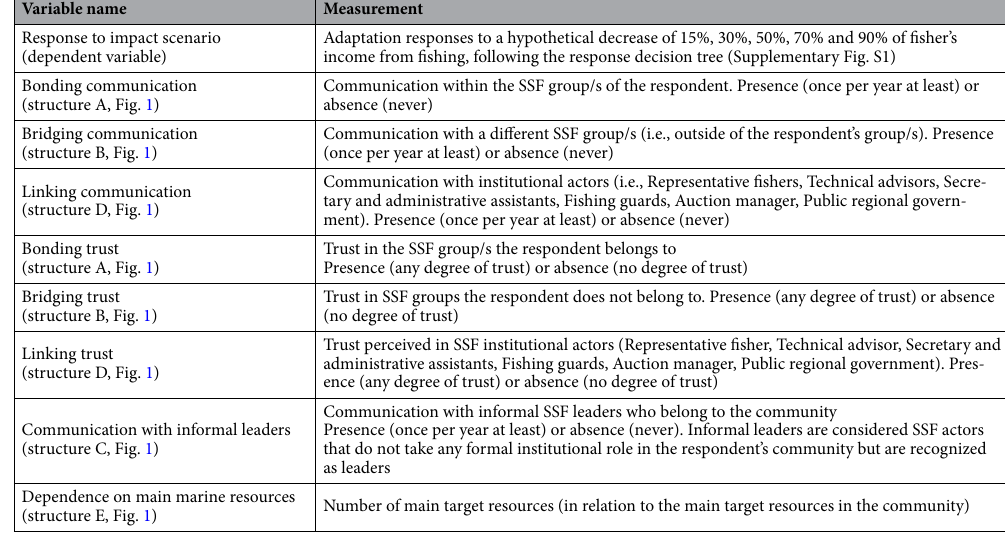
Table 1. Dependent and network structure independent variables of the five multinomial multilevel mixed effects models. The full set of variables included in the models (i.e., indicators of adaptive capacity) are further described in Supplementary Tables